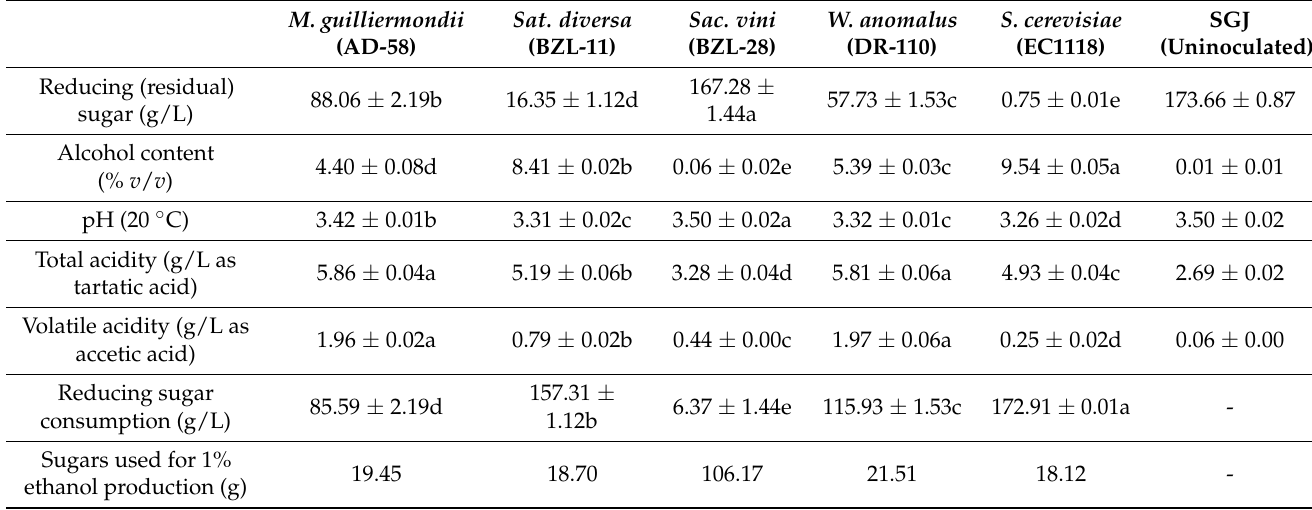
Table 1. Oenological parameter analysis of five fermented media and SGJ (mean ±